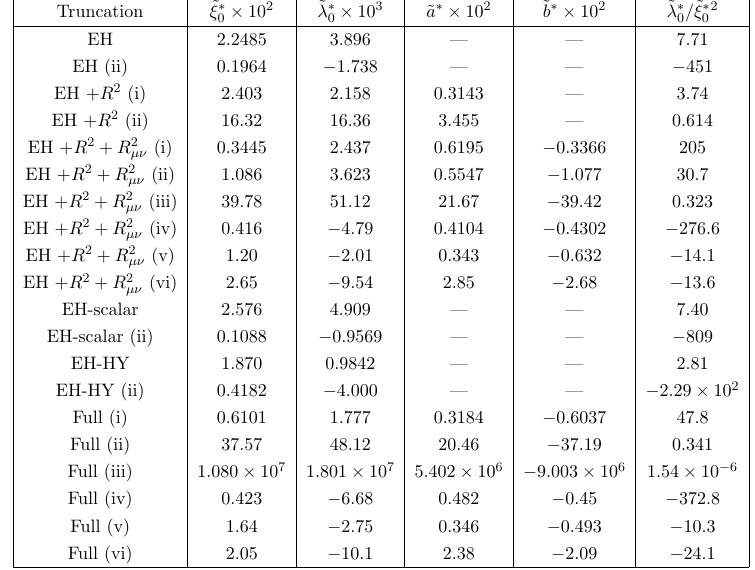
Table 7 . The values of (cid:12)xed points for (cid:11) = 0 and (cid:12) =